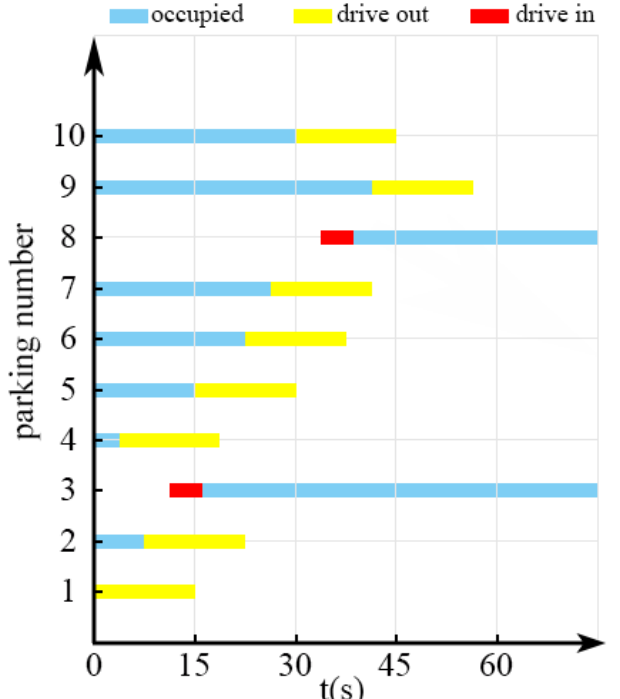
Figure 12. Identification results for all the vehicles entering and leaving the parking spaces.